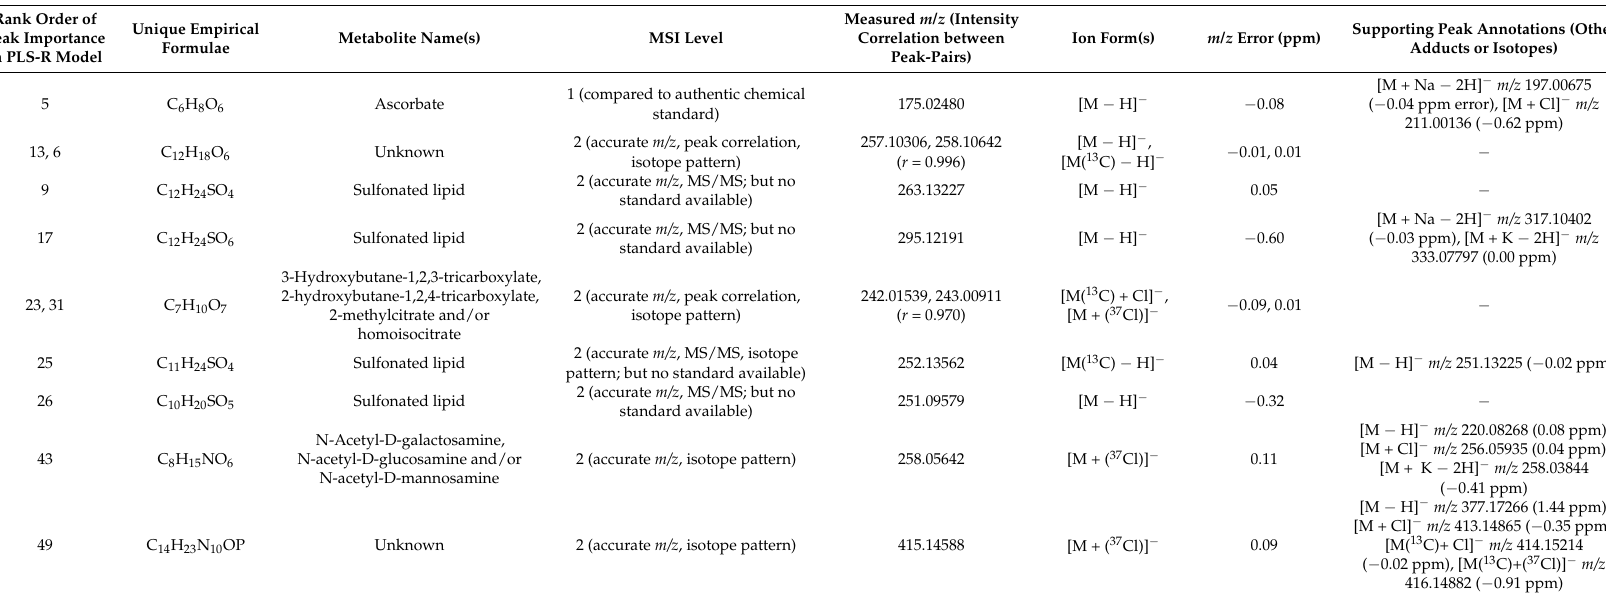
Table 1. Metabolic features within the non-chemical-specific biomarker signature that could be putatively annotated or identified with a unique empirical formula and/or metabolite name (i.e., to MSI level 1 or